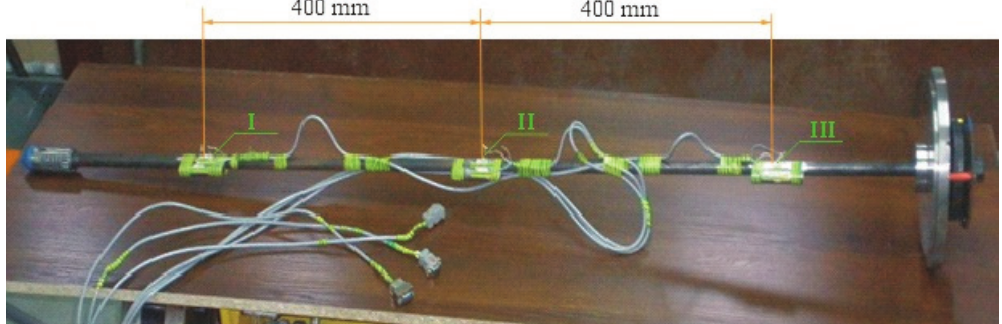
Fig. 7. View of the rock bolt instrumented with resistant strain gauges I, II, III – positions of the gauges